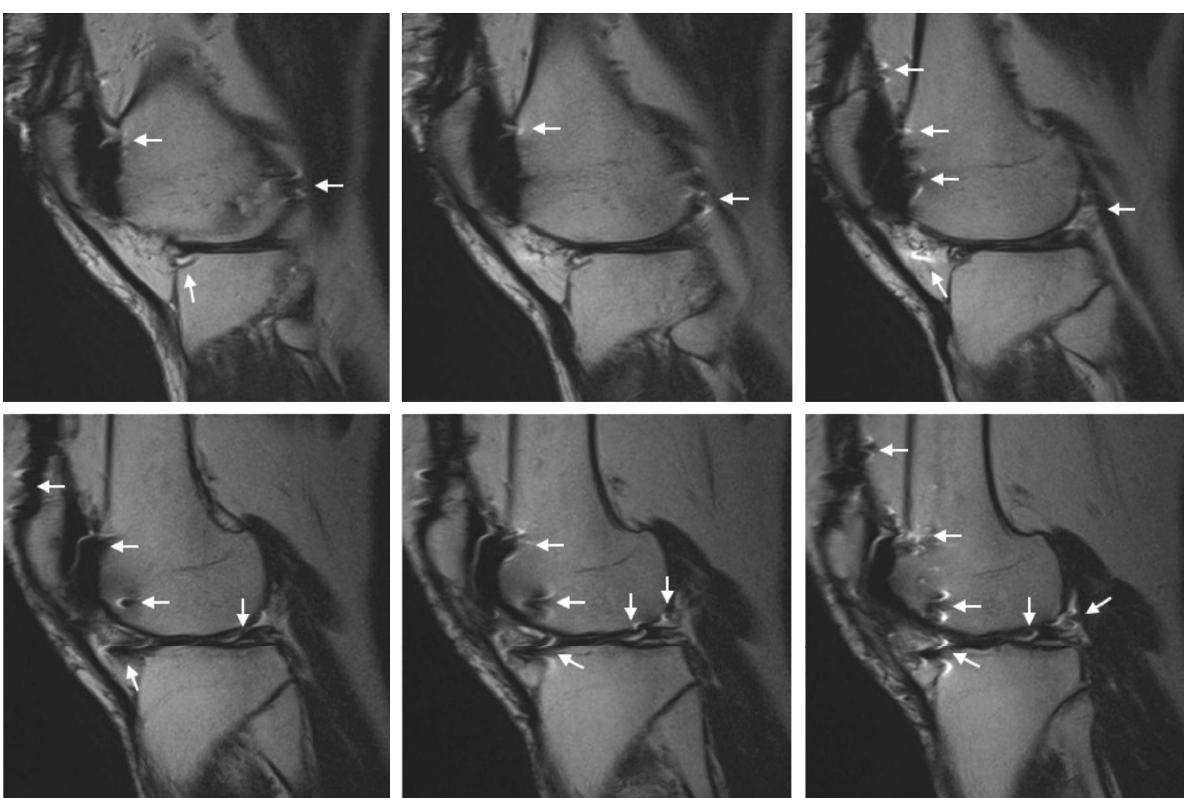
Figure 3: Sequential sagittal T2-weighted metal reduction MR images of the right knee lateral compartment. The presence of metal artifacts (white arrows) obscures accurate evaluation of the lateral meniscus.